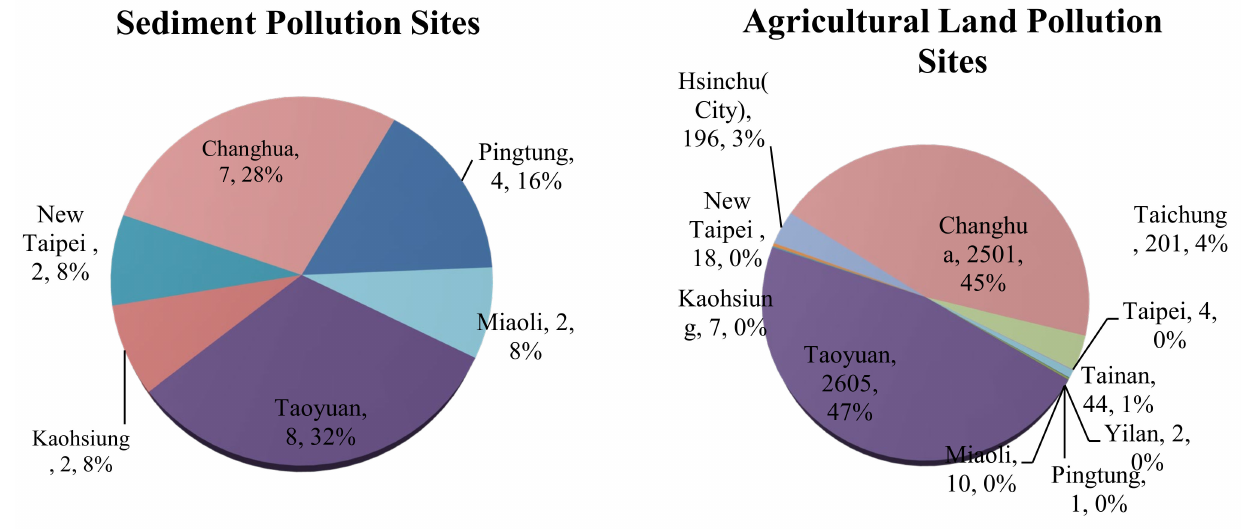
Figure 6. Pie charts of sediment and agricultural land pollution sites containing